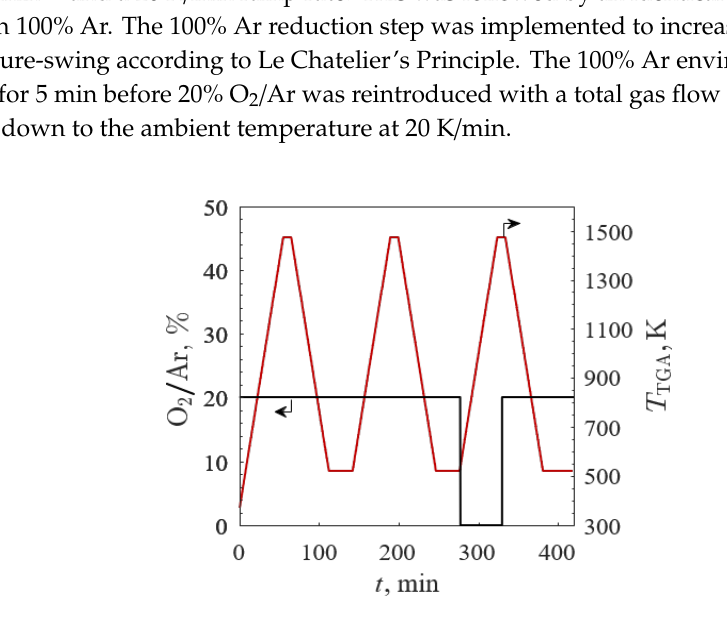
Figure 3. O 2 concentration in Ar (black line) and temperature (red line) profiles versus time between 523 and 1473 K in 20% O 2 / Ar and 100% Ar for second TGA screening.